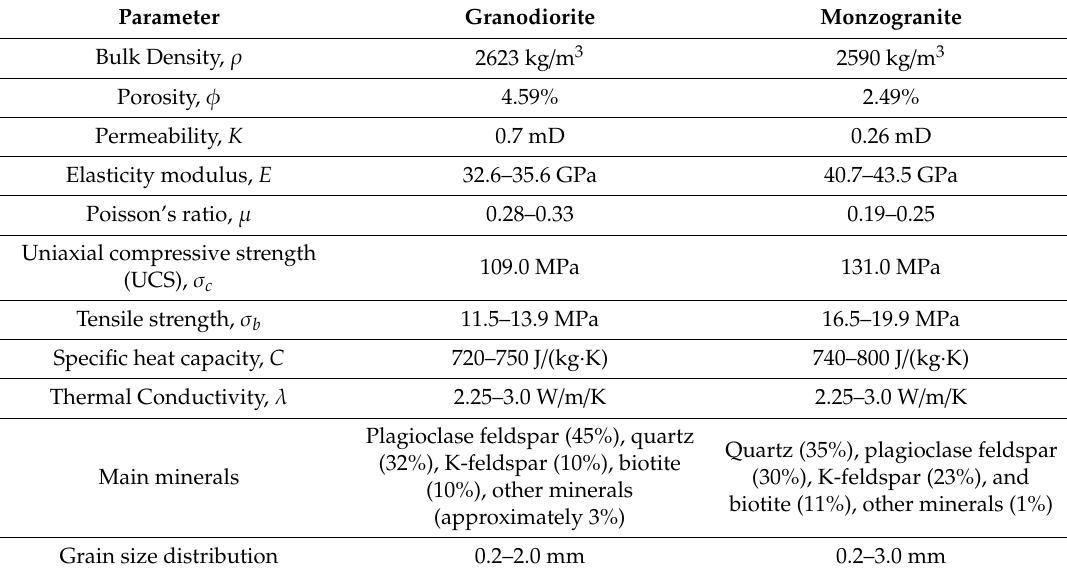
Figure 2. View of samples; ( a ) Granodiorite and ( b ) Monzogranite. Figure 2. view of samples; ( a ) Granodiorite and ( b ) Monzogranite. Table 1. The parameters of the granite Table 1. The parameters of the granite specimens.